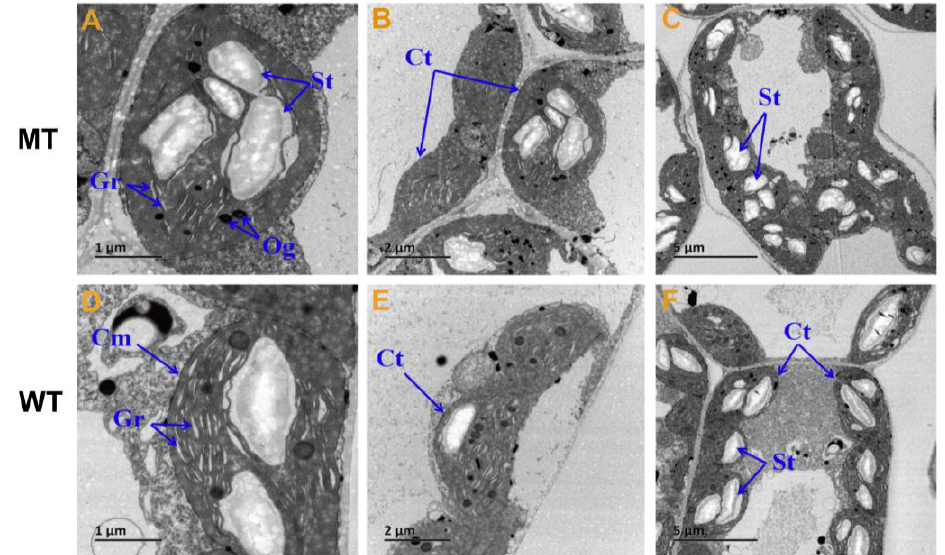
Figure 2. The ultrastructure of chloroplast in MT and WT. ( A , D ) Bar = 1 um; ( B , E ) Bar = 2 um; ( C , F ) Bar = 5 um; Ct, chloroplast; St, starch granules; Gr, grana; Cm, chloroplast outer membrane; Og, osmiophilic globule; MT: the chlorophyll deficiency mutant with yellow-green leaf color; WT: wild type with the normal green leaf color.